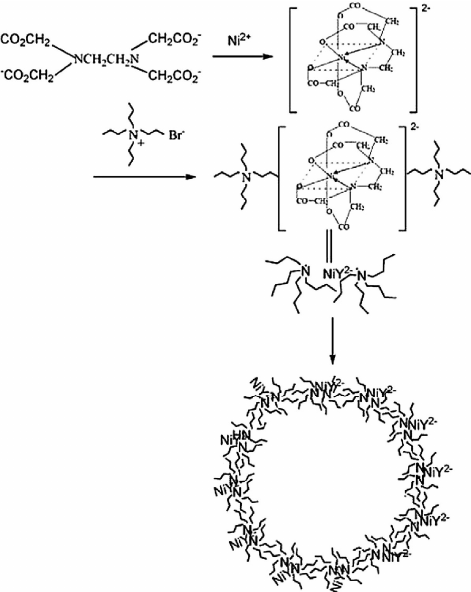
Figure 2. Template synthesis mechanism of zeolite Ni-MFI. Reproduced from [22]. Copyright Elsevier 2009.